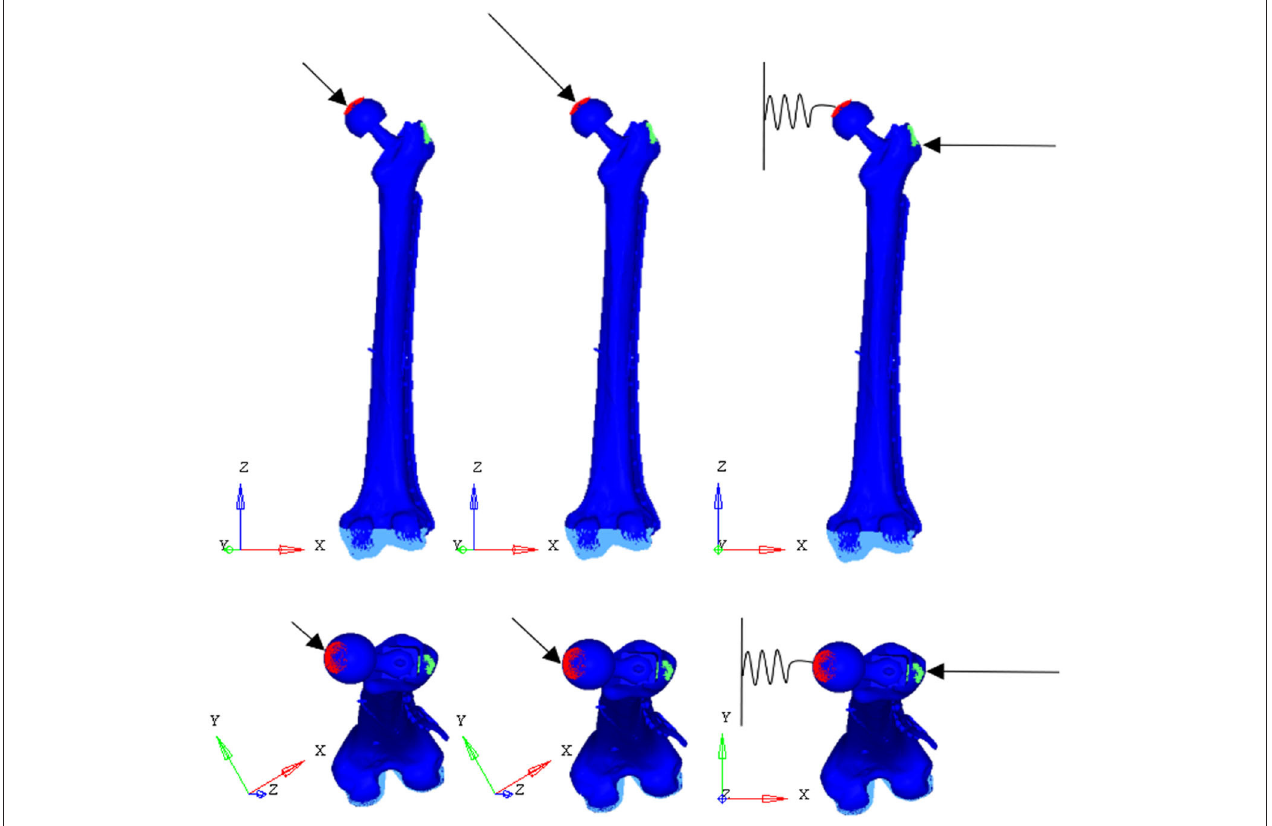
FIGURE 7 | Applied load conditions: walking (Left) (Bergmann et al., 2001), stumbling (Middle) (Bergmann et al., 2004), and falling (Right) (Aldieri et al., 2018b).